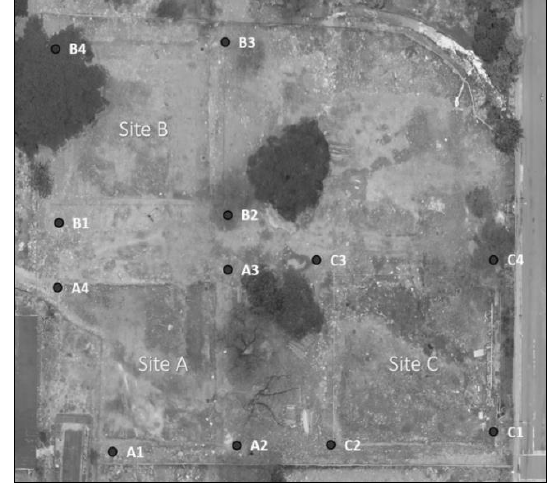
Figure 2. Aerial photo of the study area showing the three planned building sites (A, B, and C)